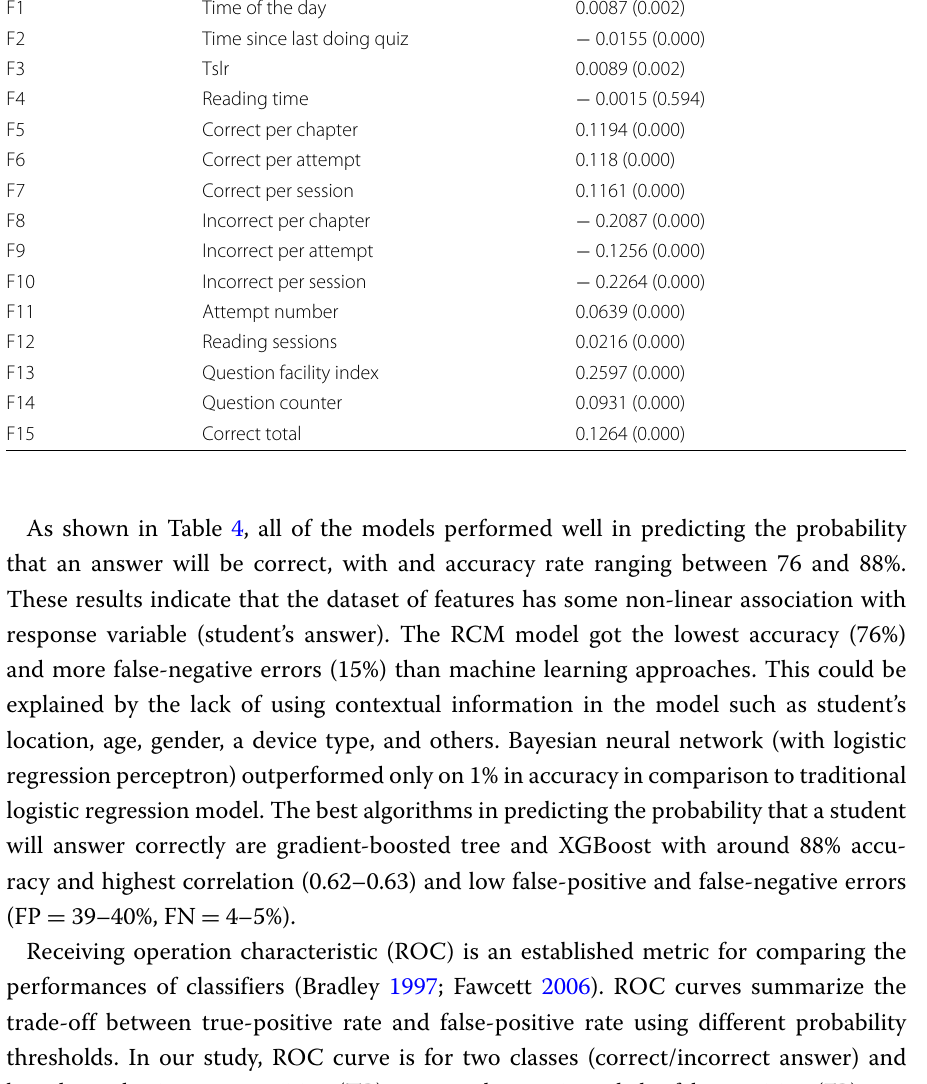
Table 3 Correlation coefficients of students’ online learning activities and quiz performance N